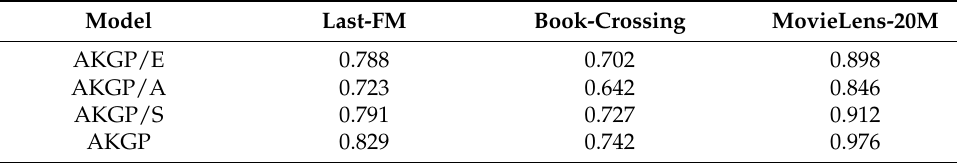
Table 4. Comparison of performance among variations of AKGP.